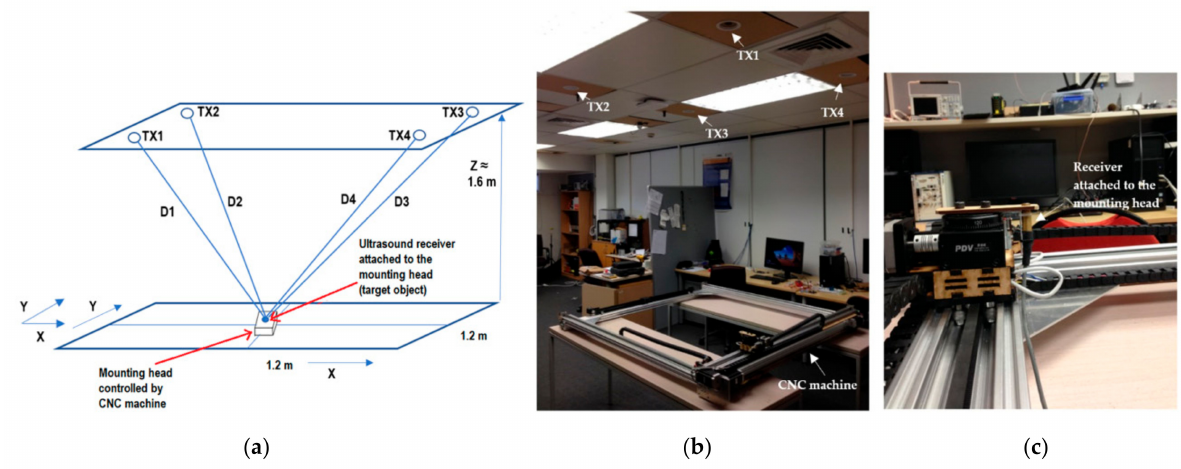
Figure 7. The diagram in ( a ) shows the UIL system set up. The actual UIL test rig with CNC machine below is shown in photo ( b ). A closeup view of the receiver microphone on the CNC is shown in photo ( c ). UIL: ultrasound indoor localization; CNC: computer numerical